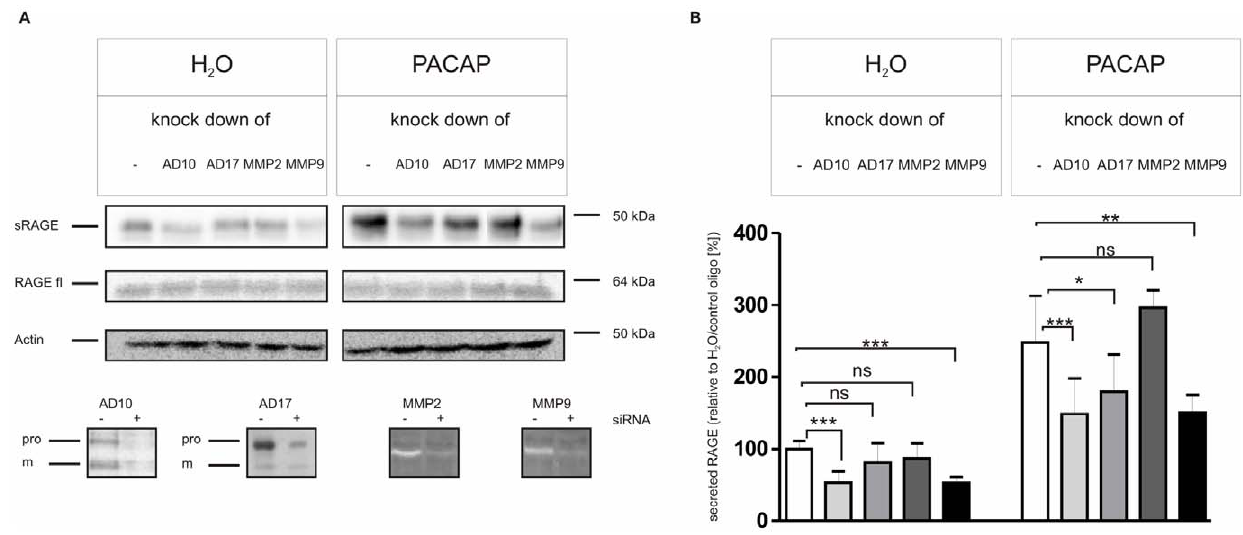
Figure 8. Effects of RNAi-mediated knock-down on the shedding of RAGE. PAC1/RAGE cells were transfected with stealth RNAi oligonucleotide duplexes (Invitrogen) targeting either ADAM10 (AD10), ADAM17 (AD17), MMP9 or MMP2. As control (-) cells were transfected with a stealth RNAi control oligonucleotide duplex (Invitrogen). Experiments were performed 48 h after transfection. Secretion of RAGE was analyzed under unstimulated (H 2 O, n=10) and PACAP-induced (300 nM, n=5) conditions for 3 h. (A) Typical Western blots and gelatin zymography are shown, (B) Quantitative analysis of secreted RAGE. RAGE secreted into the cell culture supernatant and full-length RAGE in cell lysates were detected with antibody Mab5328. The enzymatic activity of MMP9 and MMP2 in cell culture supernatants was determined by gelatin zymography as described in Materials and Methods. In cell lysates full-length RAGE (fl-RAGE), ADAM10 (pro and mature (m) forms), and ADAM17 (pro and mature (m) forms) were detected with suitable antibodies (see ‘‘Materials and Methods’’). As a loading control actin was detected in cell lysates by Western blotting. Shown in the quantitative analysis (B) are the mean effects 6 S.D., significance was determined by the One-way ANOVA Bonferroni test (ns = P . 0.05; * = P , 0.05; ** = P , 0.01; *** = P ,